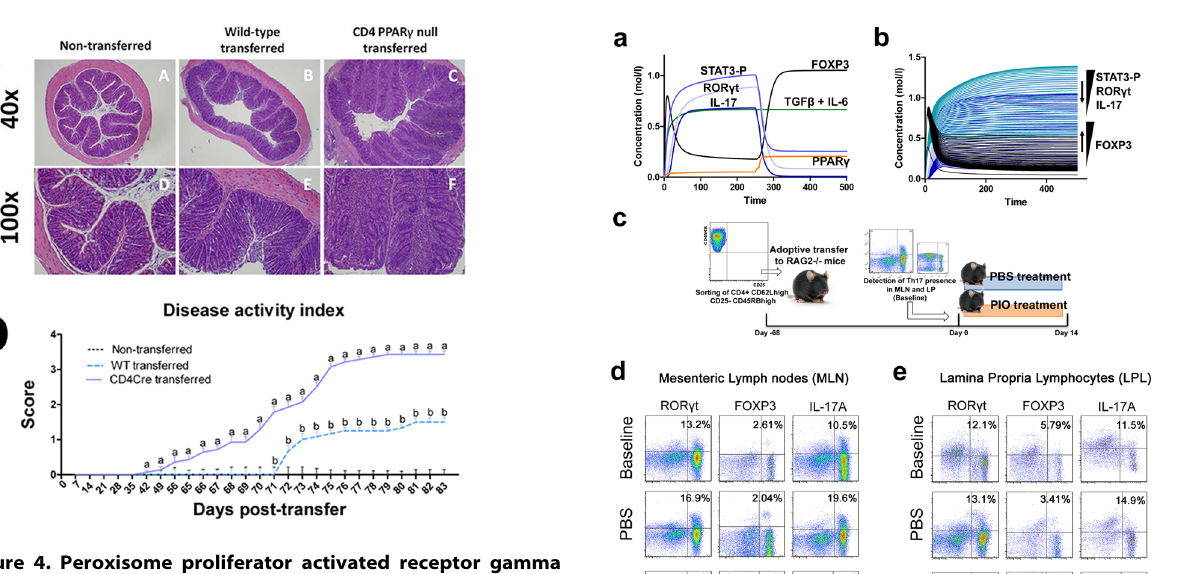
Figure 4. Peroxisome proliferator activated receptor gamma (PPAR c ) ameliorates colonic inflammation and clinical signs of disease. (A) SCID recipients were administered either wild-type or PPAR c null naı¨ve CD4 + T cells. Representative photomicrographs of colons from (A.A–A.D) non-transferred (A.B–A.E) wild-type recipient and (A.C,A.F) T cell-specific PPAR c null recipient mice. Original magnification 40 or 100 6 . (B) Disease activity scores of SCID recipient mice of wild- type or PPAR c null naı¨ve CD4 + T cells. Data are represented as mean 6 standard error. Points with an asterisk are significantly different when compared to the PBS-treated group ( P , 0.05).